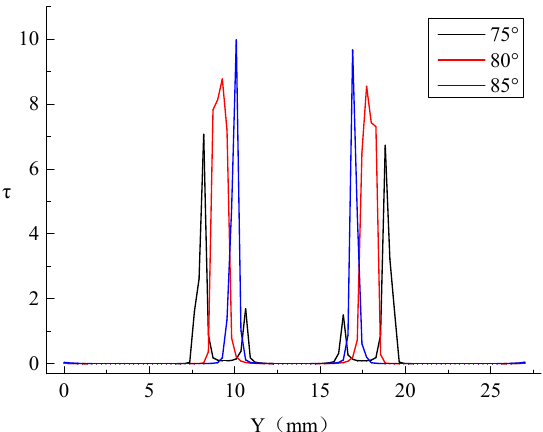
Figure 9. Coefficient distribution of pressure pulsation at the trailing edge monitoring lines under different fully opening angle conditions at a flow rate of 5 L/min.